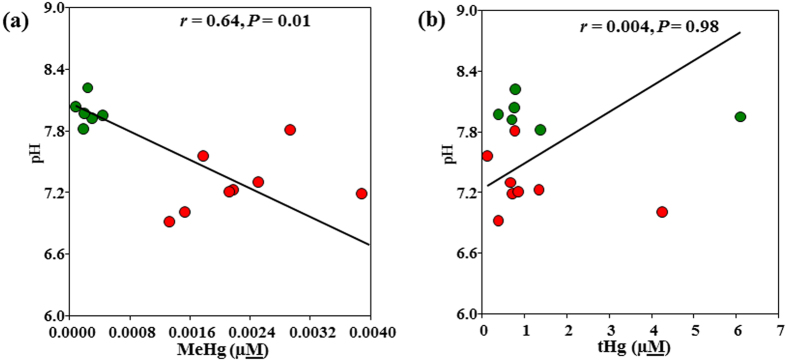
The correlations between pH and MeHg (a), pH and tHg (b). Red and green dots represent high and low MeHg samples, respectively. Linear regressions were used to test Pearson’s correlation between DWW samples with high and low mercury levels and pH.